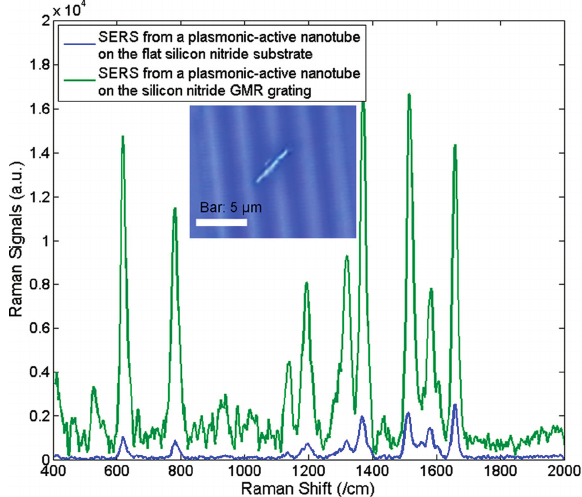
Figure 9. Raman Spectra of 1 µM R6G detected from a plasmonic-active nanotube on a flat Si 3 N 4 substrate (blue) and from a plasmonic-active nanotube on the GMR optical grating (green). With permission from [85].